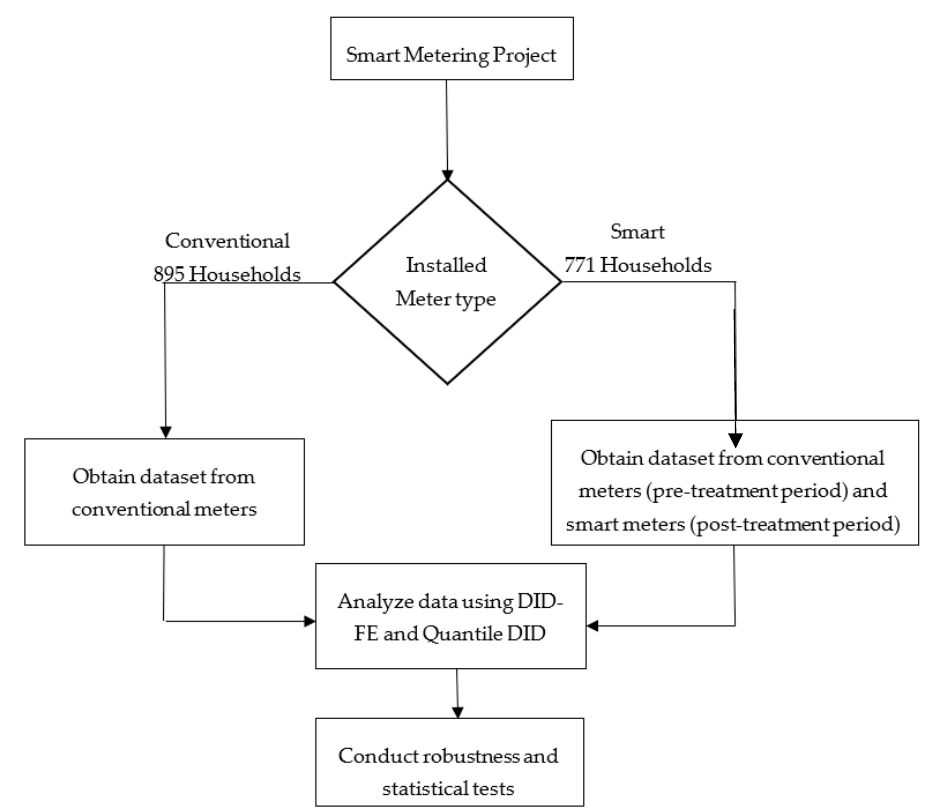
Figure 1. Flowchart diagram.